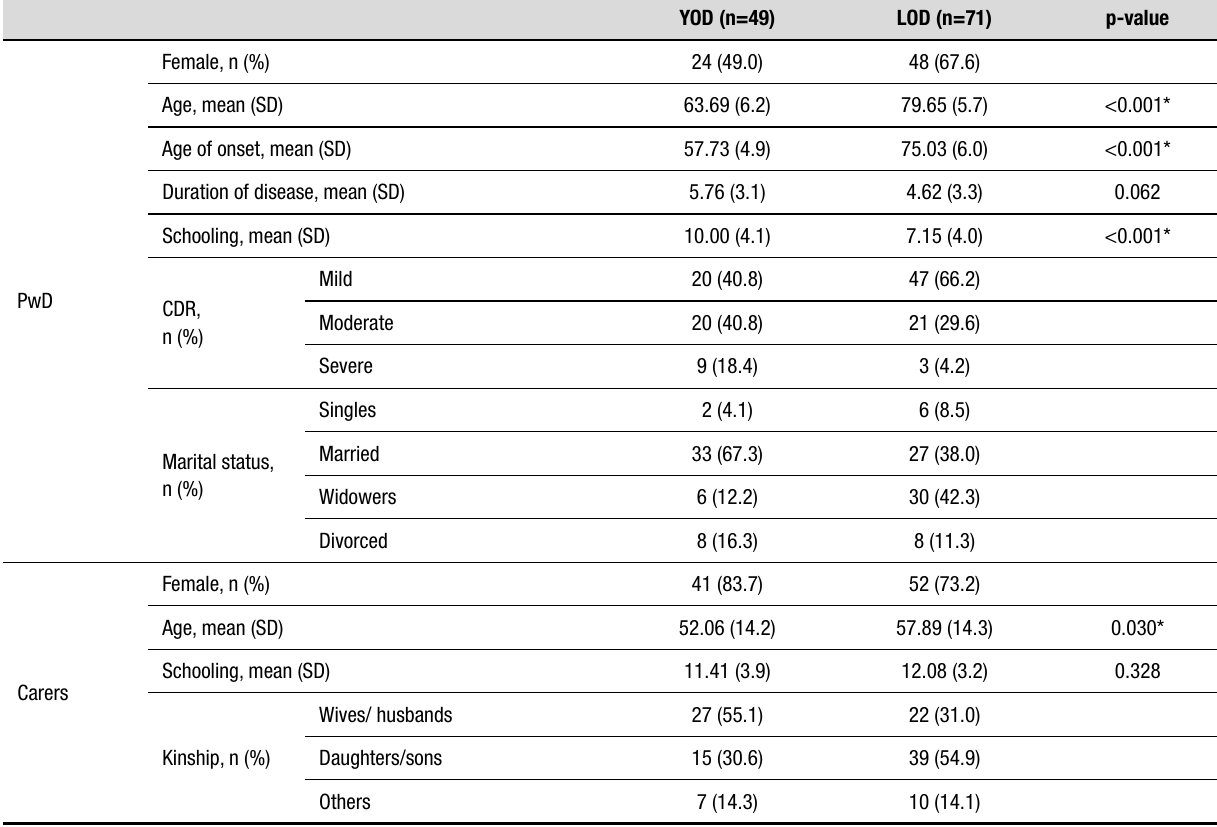
Table 1. Sociodemographic characteristics of people with dementia and carers according to age of onset.